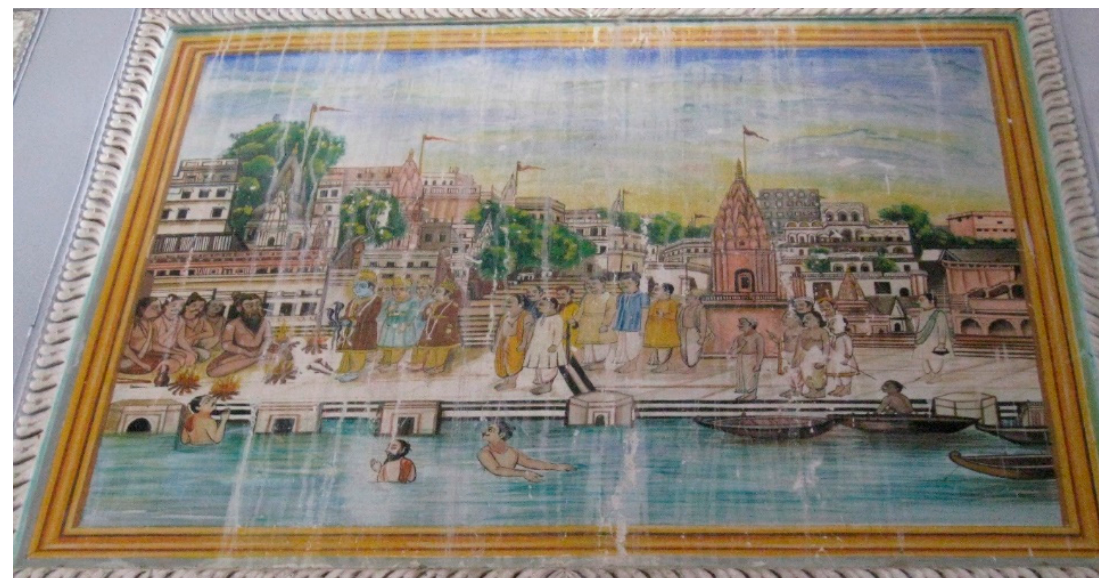
Figure 9. A painting of P ā r ś va’s instruction of Kama ṭ ha in the Ś rey ā ṃ san ā th Digambar Mandir, Sarnath. Twentieth century.